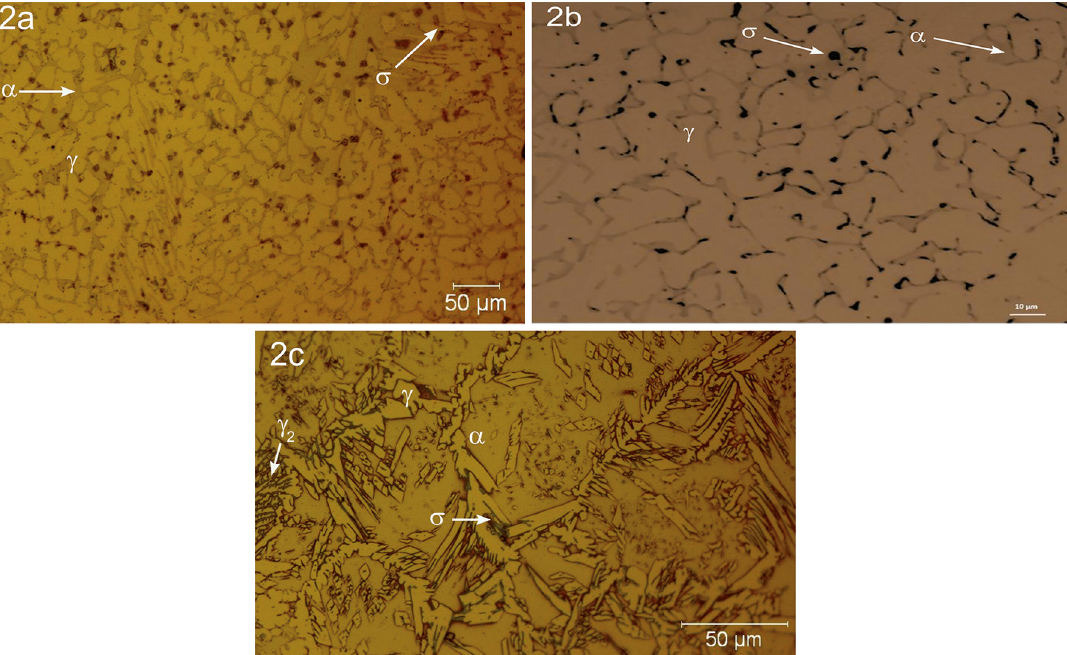
Figure 2. Microstructure of the welding metal corresponding to the root pass with the presence of austenite, ferrite and sigma phase. Table 3. Chemical composition of ferrite, austenite and sigma phase in the welding metal